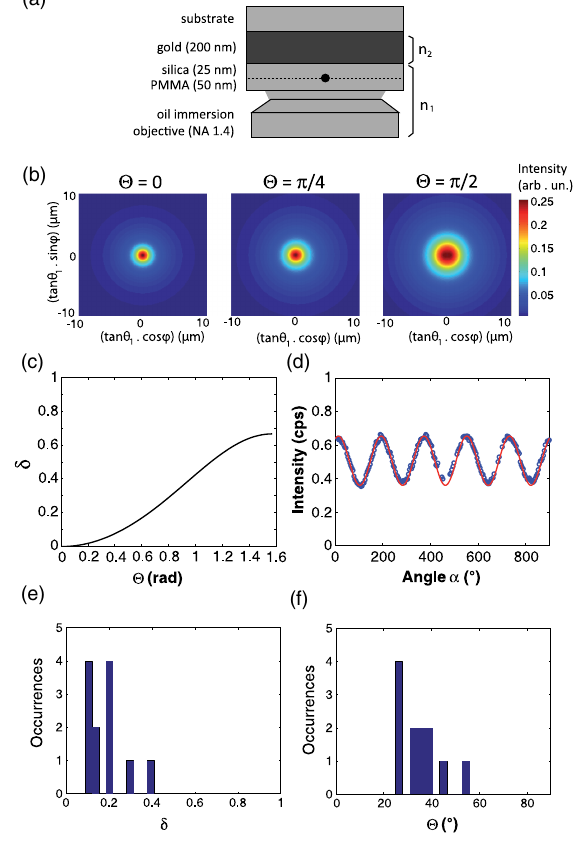
FIG. 8. (a) Schematic of the experimental system. (b) Calculated emission pattern for a 2D dipole with ( Θ ¼ 0 , Φ ¼ 0 ), ( Θ ¼ ð π = 4 Þ , Φ ¼ 0 ), and ( Θ ¼ ð π = 2 Þ , Φ ¼ 0 ). (c) Calculated values of δ as a function of the angle Θ for a 2D dipole ( c -axis inclination). (d) Circles: Dependence of the x -polarized emission intensity as a function of the half-wave plate angle for a nanocrystal of CdSe/CdS in the vicinity of gold-dielectric inter- face, fitted (solid red line) with Eq. (26). From the fit, we deduce that Θ ¼ 46 ° and Φ ¼ 69 °. (e) and (f) Histograms of experimental values of δ and Θ for 12 CdSe/CdS nanocrystals situated 50 nm from a gold